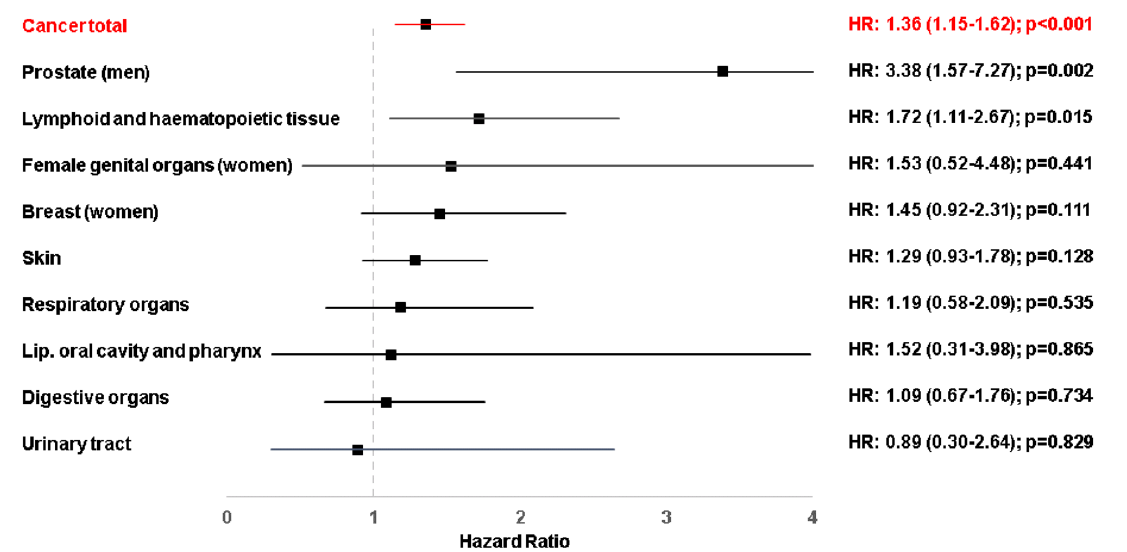
Figure 3. Association between chronic gingivitis and the incidence of different cancers in patients followed for up to 10 years in general practices in the United Kingdom.